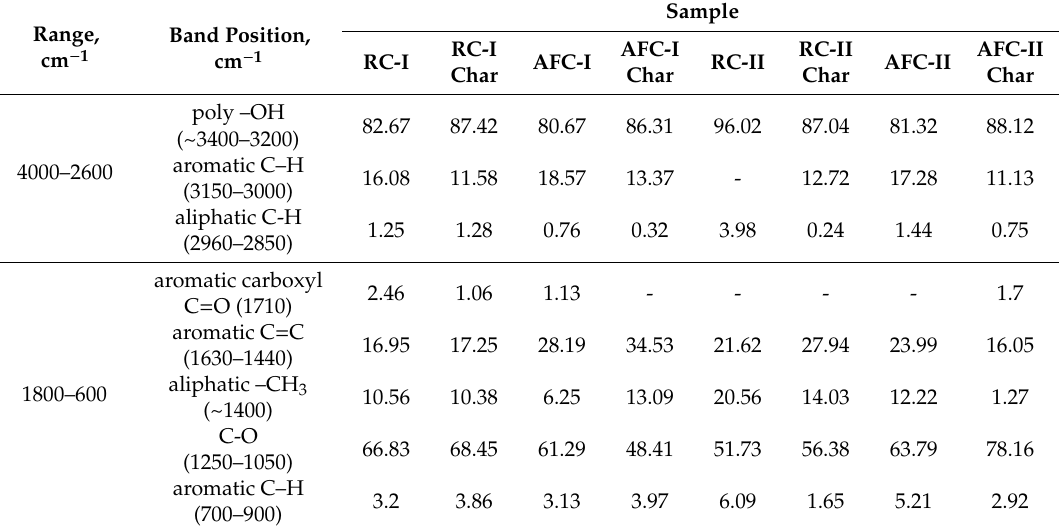
Table 5. The band ratios of the samples at each region (%, dry basis).